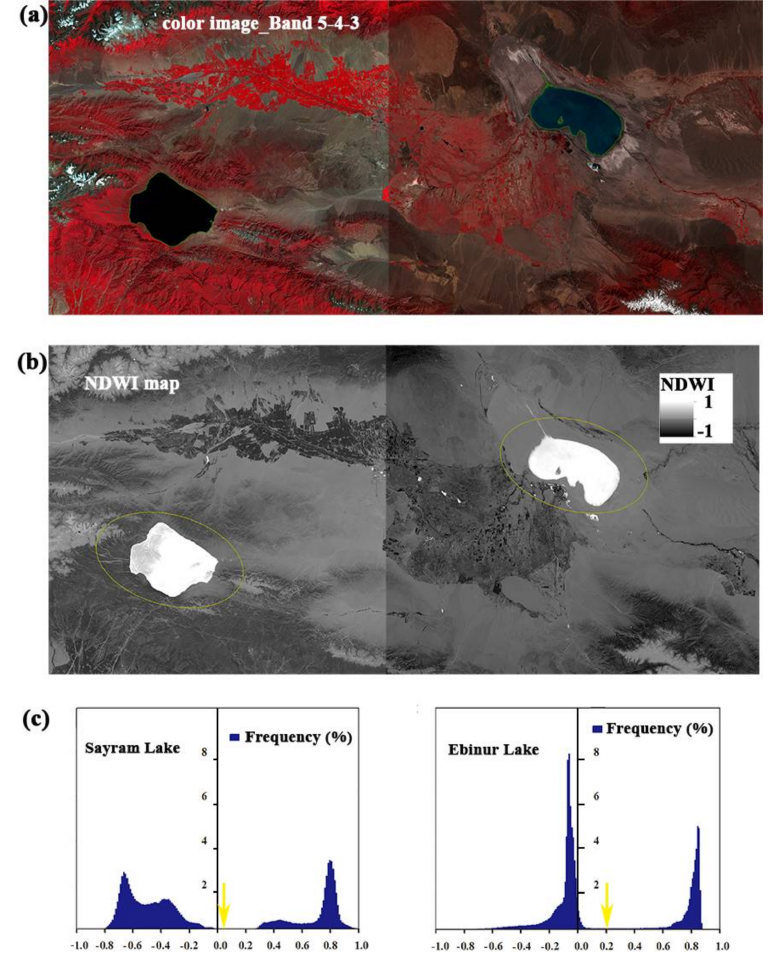
Figure 2. Representative lake water extent mapping based on NDWI: ( a ) A false-color RGB composition of Bands 5, 4, and 3; ( b ) NDWI map; ( c ) Distribution of spectral